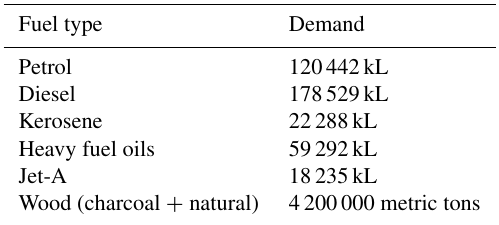
Table 2. Fuel demand in Rwanda (2016, Rwanda Ministry of In-